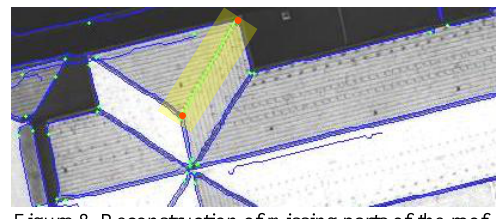
Figure 8. Reconstruction of missing parts of the roof.